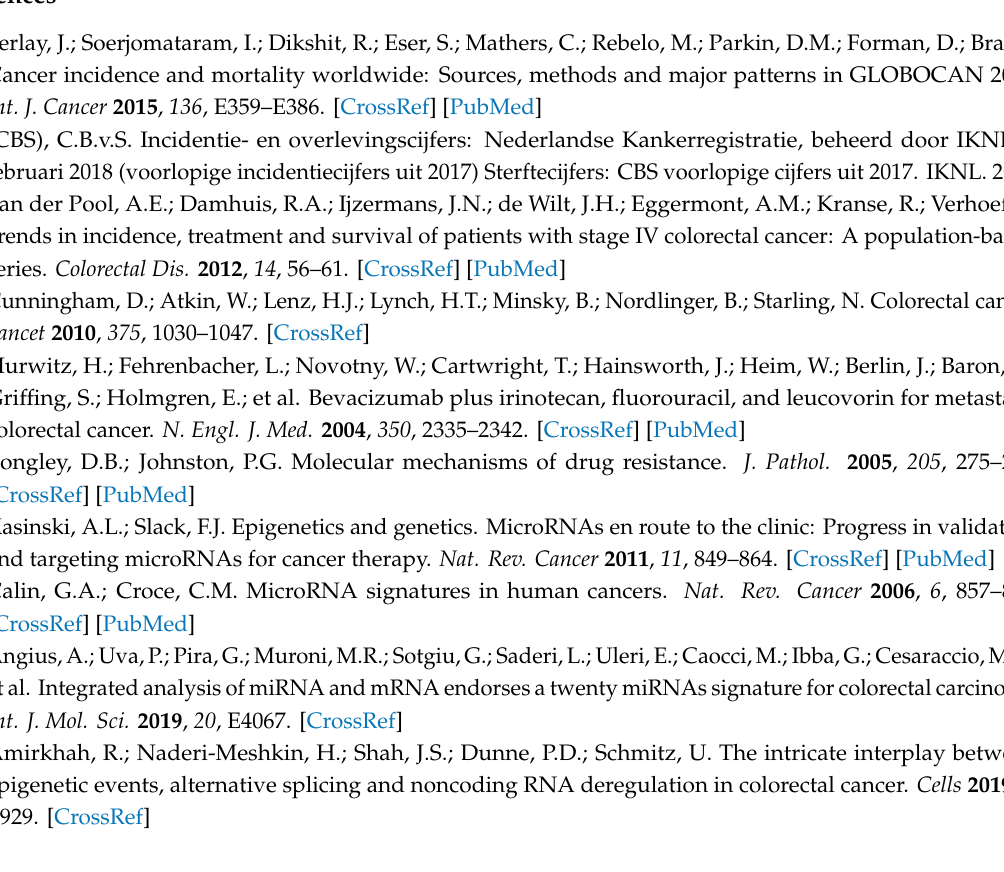
Figure S1: Workflow and datamining of proteomics data, Figure S2: Cell viability and clonogenic assays of DLD1 and SW480 cells after treatment with chemotherapy, and mRNA expression in SW480 cells, Figure S3. Unsupervised cluster analysis of detected peptides in CRC cells. Figure S4: Supervised cluster analysis of di ff erentially expressed peptides between wild-type cells and negative control transfected cells. Figure S5: Supervised cluster analysis of di ff erentially expressed peptides between negative control transfected cells and cells transfected with miR-195-5p and miR-497-5p mimics, Table S1: Cell line characteristics of RKO, HCT116, SW480, and DLD1, Table S2: Significant up- and downregulated peptides after transfection of CRC cells with miR-195-5p mimic and miR-497-5p